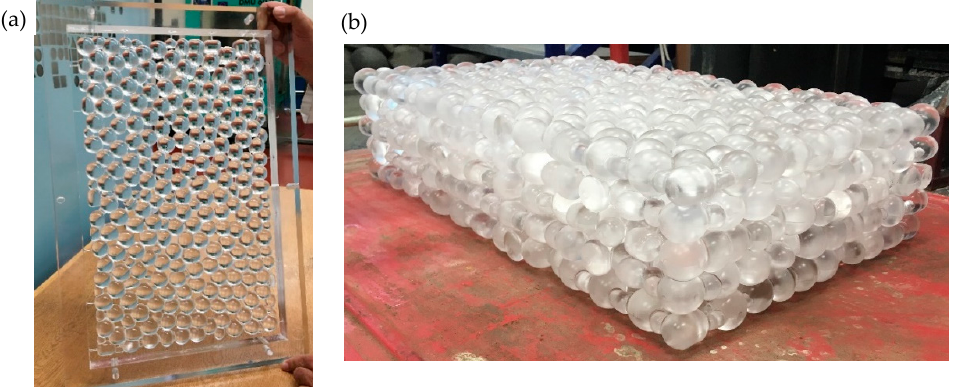
Figure 4. ( a ) A typical completed sheet with the frame still attached, highlighting the optical clarity of the cast acrylic; ( b ) A fully stacked assembly of the artificial riverbed prior to placement within the flume, highlighting the discoloration of the cast acrylic with time.